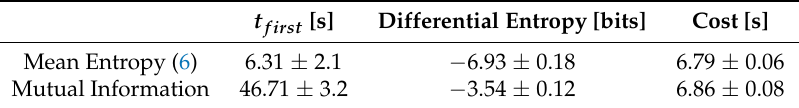
Table 1. Analysis of the information function. We compare Equation (7) with the MI, in terms of: time to find a first ( t first ), process differential entropy that results after measuring along P x r , s ∗ output by Algorithm 3, and cost of the resulting path. Results correspond to the average calculated over 40 simulations